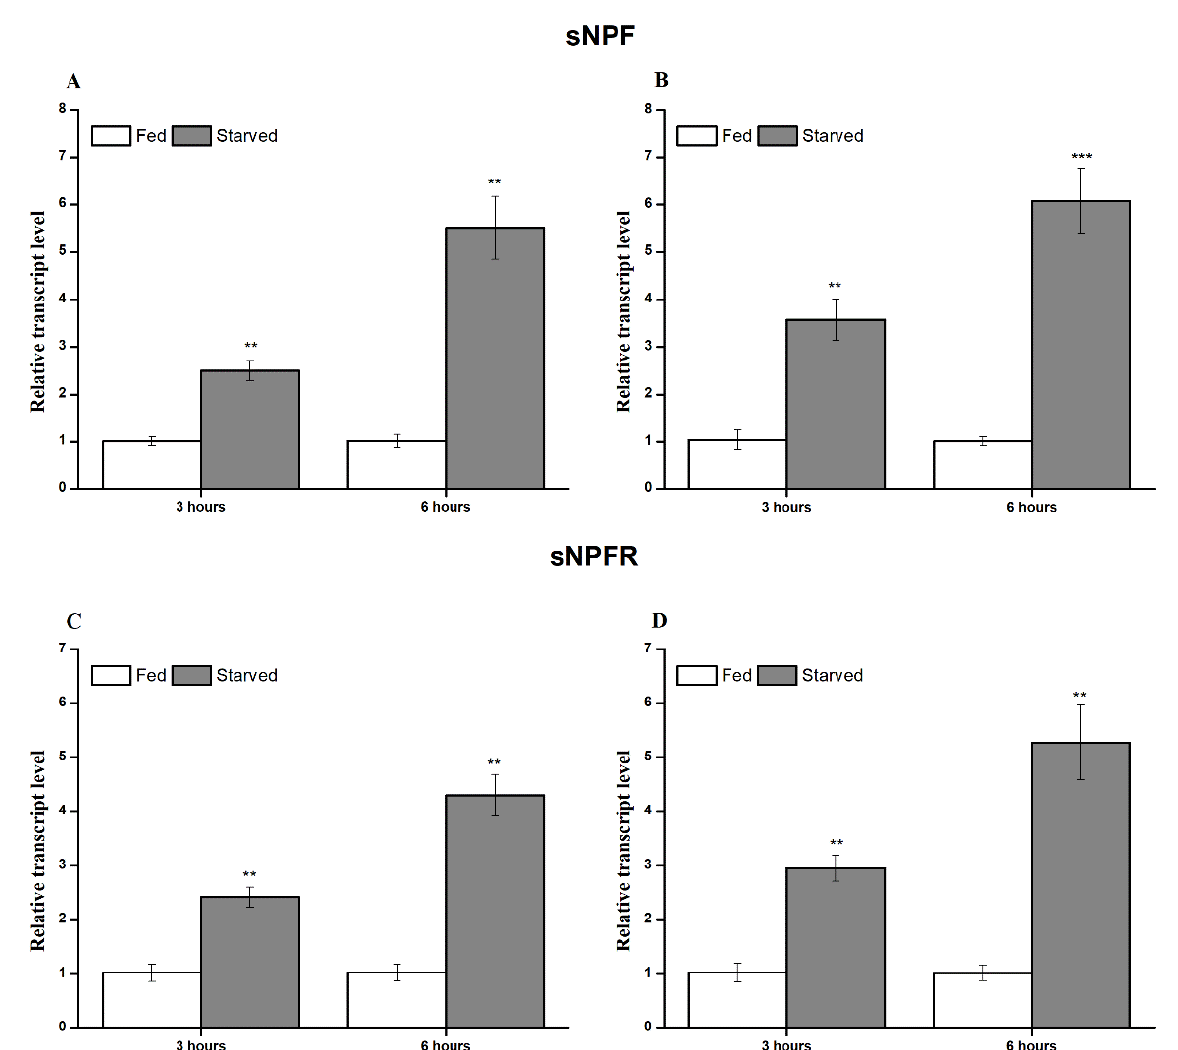
Figure 5. Effect of starvation on the transcript expression of ApsNPF and ApsNPFR in the adult whole body ( A , C ) and central nervous system (CNS) ( B , D ). The bars correspond to the average of three independent biological replicates. Results are shown as means ± S.E. Asterisks on bars indicate significant difference between the fed and the starved aphid calculated using statistical analysis (independent student t-test, ** p < 0.01; *** p < 0.001).